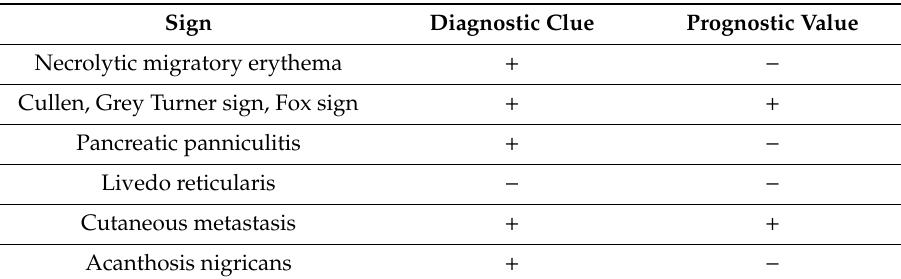
Table 3. Importance of recognizing skin lesions in pancreatic